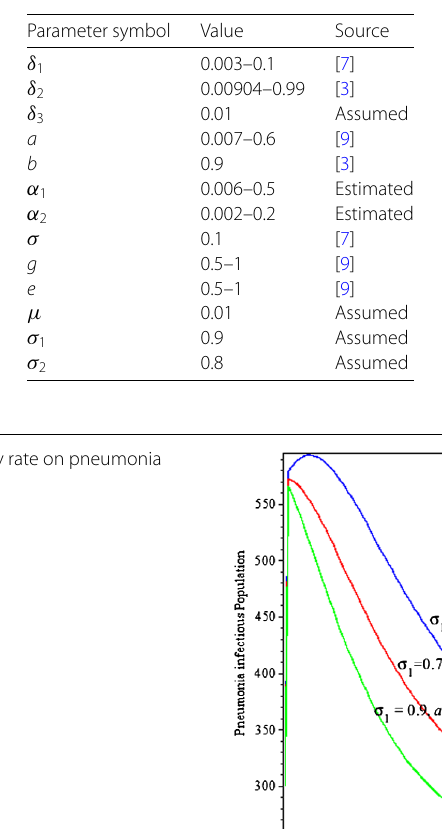
Table 2 Parameter values of the model